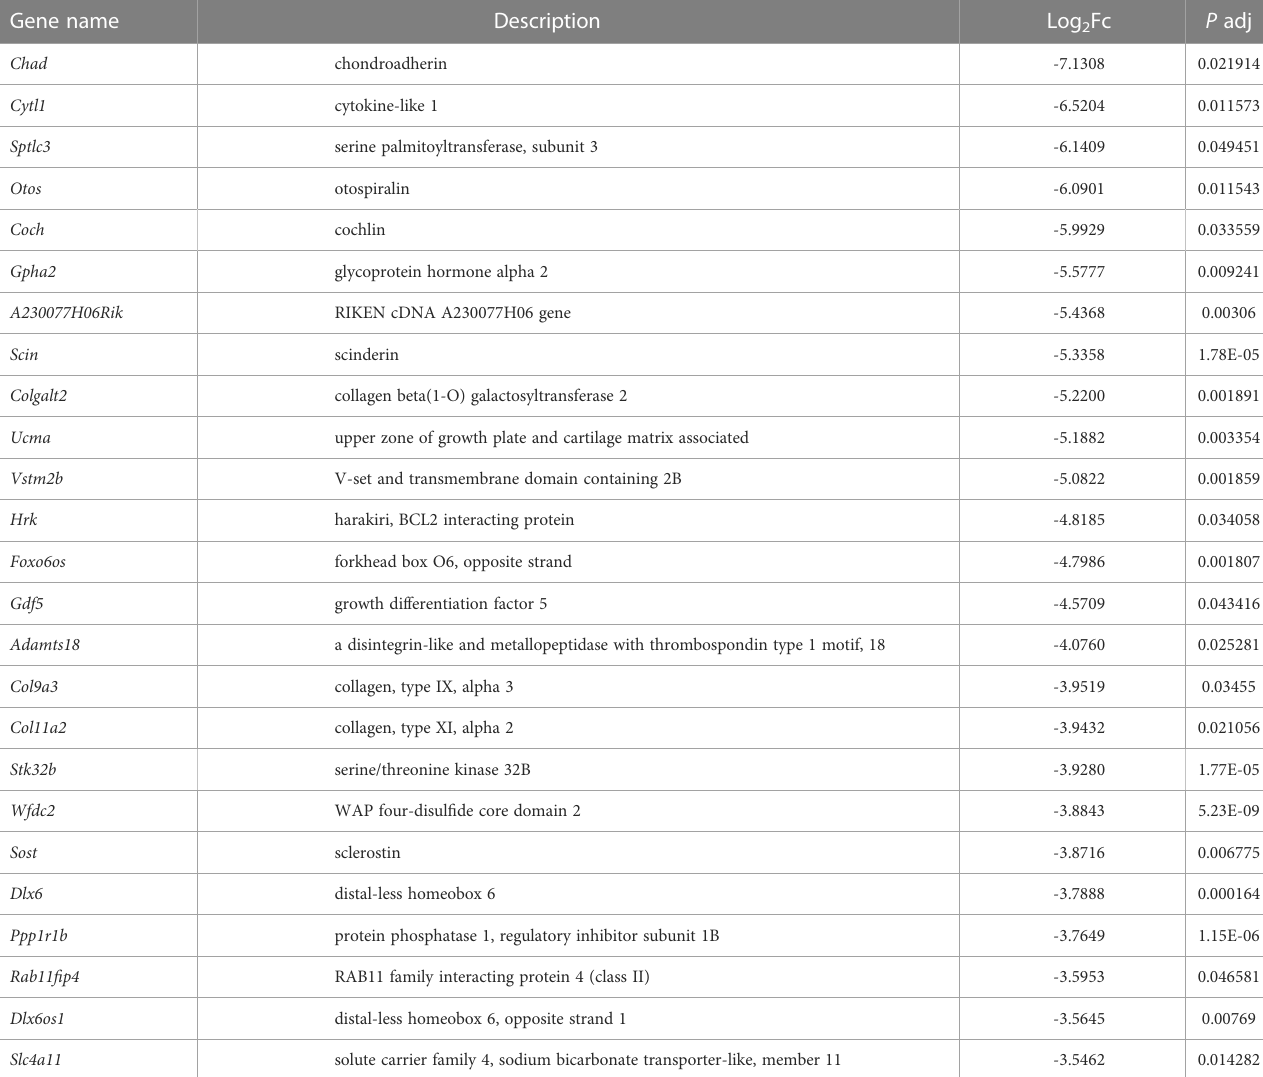
TABLE 4 The 25 most down-regulated genes in Ano5 Cys360Tyr